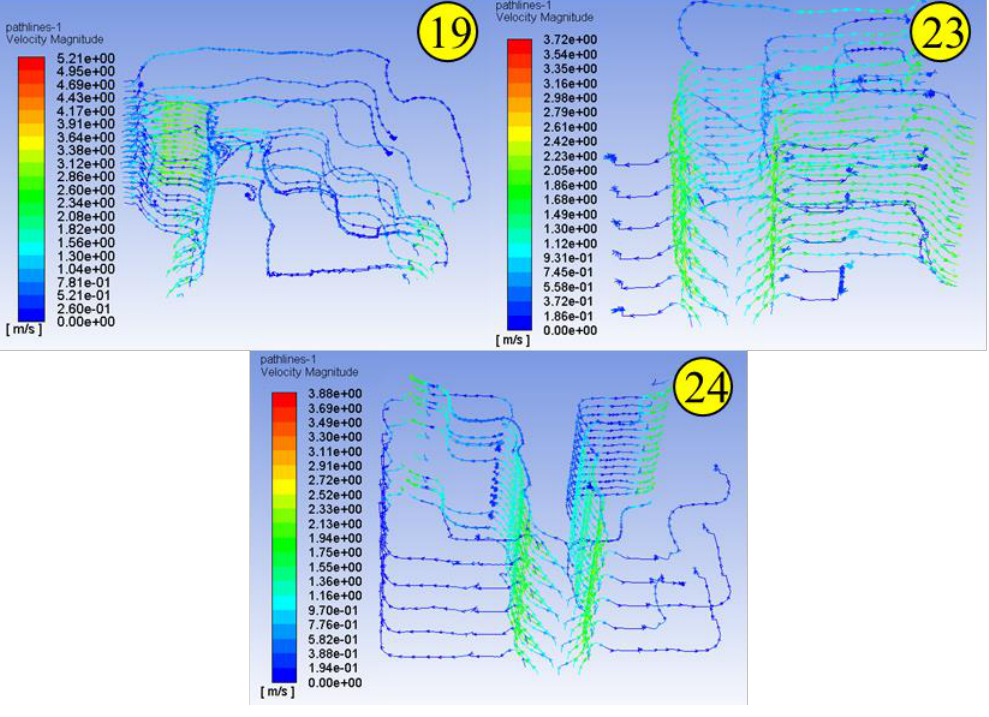
Figure 20. Velocity path line of scheme 19, 23,